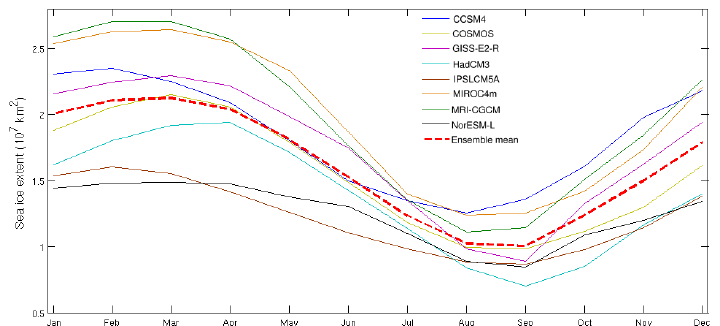
Figure 2. Annual cycle of total Arctic sea ice extent in the pre-industrial simulations for each participating model in PlioMIP Experiment 2 as well as the ensemble mean.